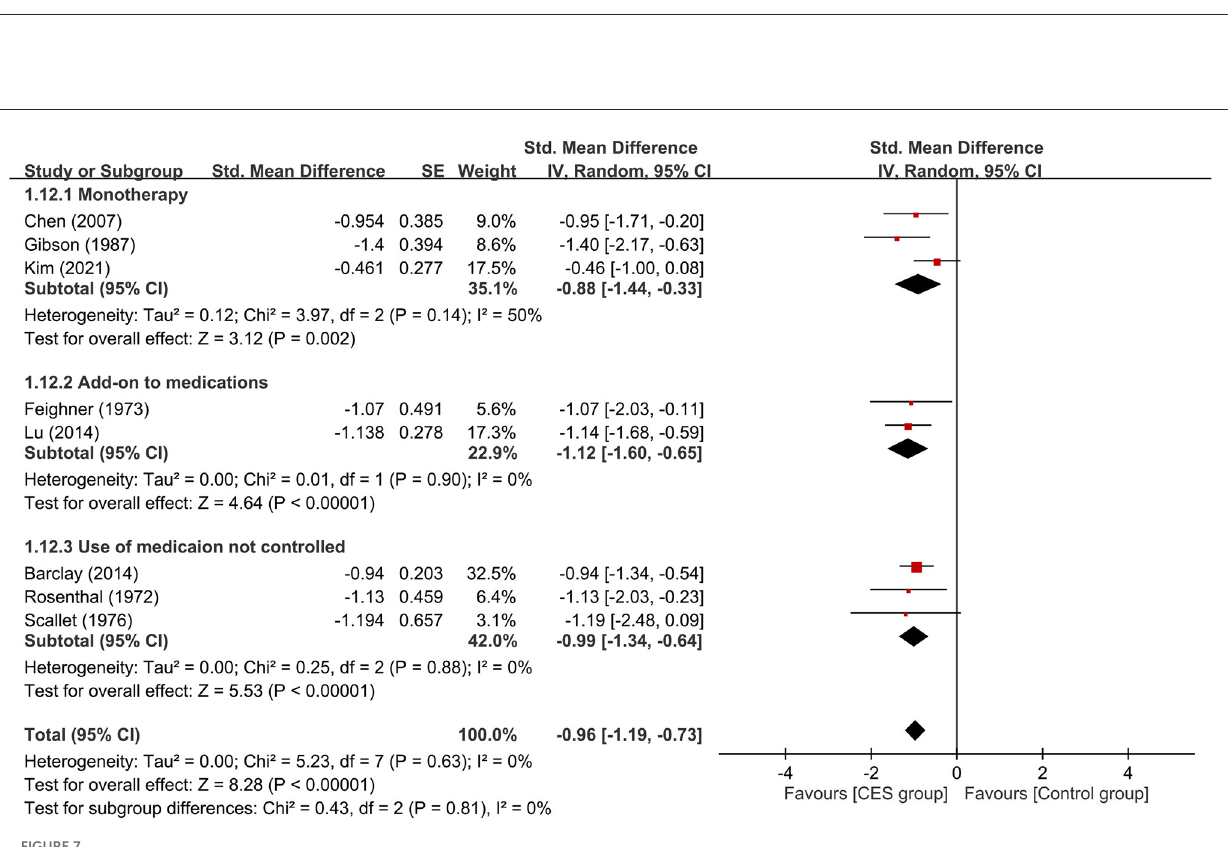
FIGURE7 Subgroup analysis of CES as monotherapy vs. add-on therapy. CES, cranial electrotherapy stimulation. CES, cranial electrotherapy stimulation; Std, standardized; CI, confidence interval; SE, standard